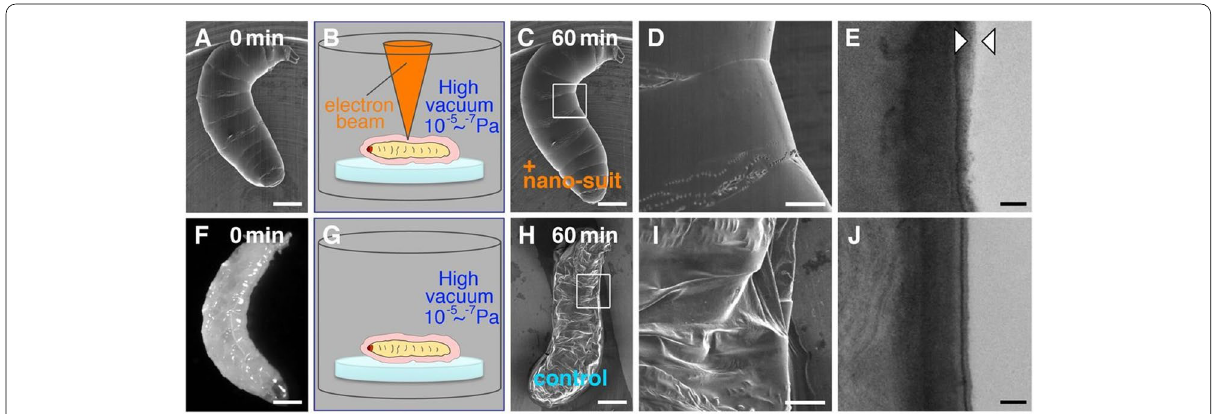
Fig. 1 Fruit fly Drosophila melanogaster larvae. A – E Larva irradiated with electron beam for 60 min. A , C , and D SEM images. B Schematic drawing. E TEM image. Arrowhead extra surface layer. F – J Larva not irradiated with electron beam for 60 min. F Optical micrograph. G Schematic drawing. H = and I SEM images. J TEM image. Bars 0.3 mm ( A , C , F , and H ), 0.1 mm ( D and I ), and 0.2 μm ( E and J ). From Takaku et al. 2013 with permission from = the